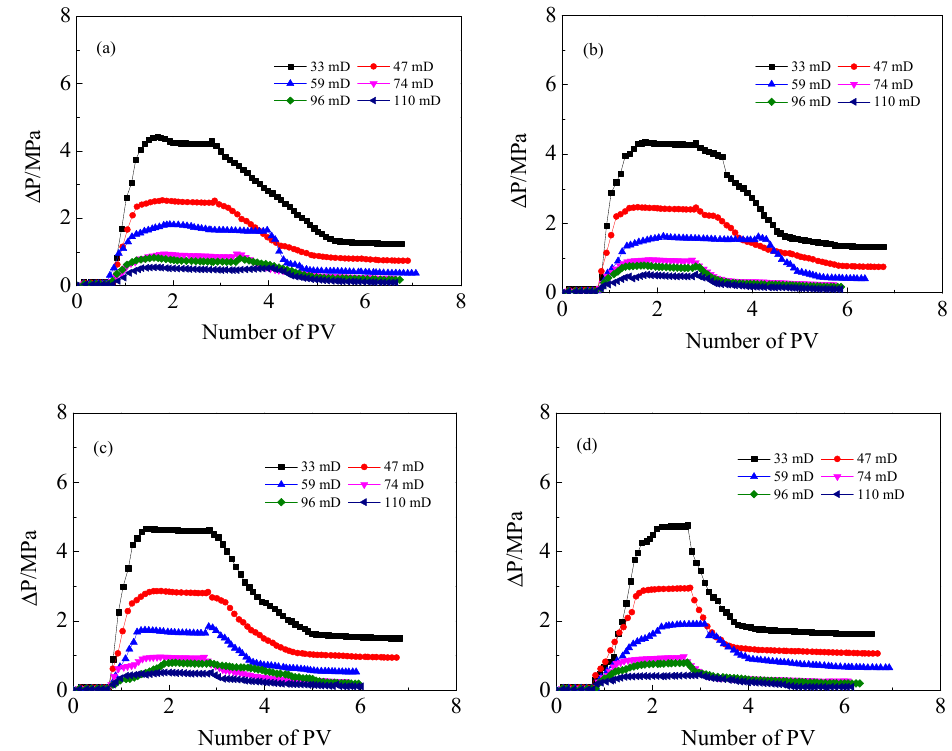
Figure 8. Pressure gradient ( ∆ P) as a function of pore volume (PV) of injected in HW-HPAM/ANS flow in different permeability cores. ( a ) 0.8 g · L − 1 , ( b ) 1.5 g · L − 1 , ( c ) 2.3 g · L − 1 and ( d ) 3.0 g · L − 1 . c ANS = 3.0 g · L − 1 .